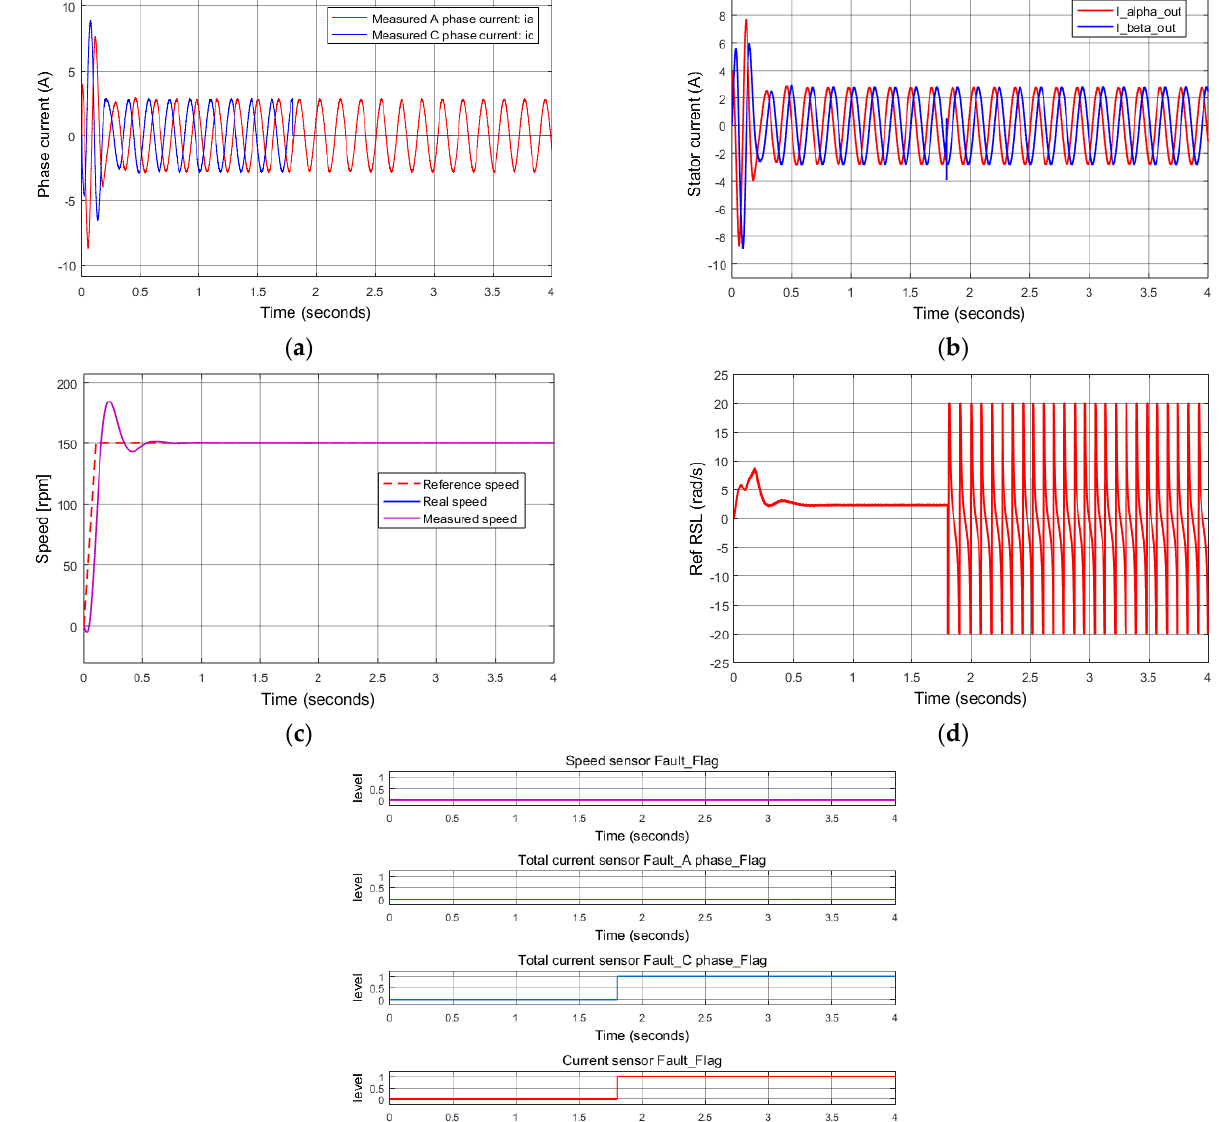
Figure 10. Simulation results: total C phase current sensor failure at 1.8 s. ( a ) Measured currents; ( b ) stator current vector components for FOC controllers (FTC outputs); ( c ) reference, real, measured speeds; ( d ) reference rotor slip; ( e ) sensor fault indications.